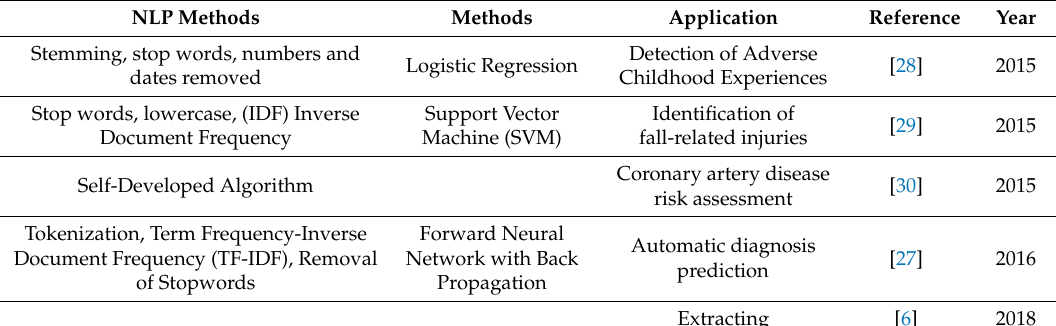
Table 2. Examples of text mining (TM) case studies from